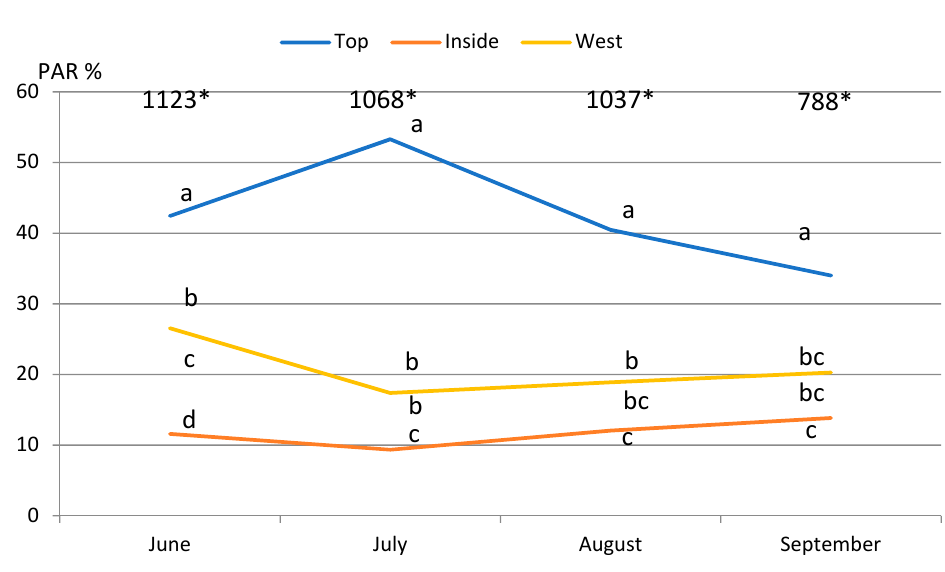
Table 1. Effect of canopy position on photosynthetic parameters, average 2019–2020.